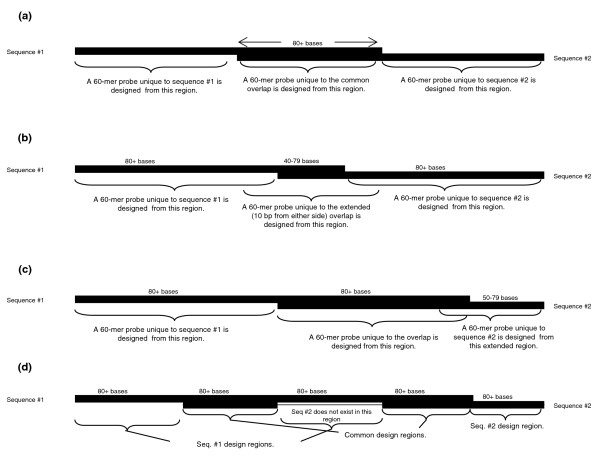
Examples of transcript clustering. Transcripts were clustered by BLAT and then aligned in ClustalW. Some of the more common clustering patterns are depicted. (a) Two transcripts, each with a unique region of at least 80 bases and a common region of at least 80 bases; (b) two transcripts, each with a unique region of at least 80 bases, and a common region between 40 and 79 bases; (c) two transcripts with a common region of at least 80 bases, a unique region of at least 80 bases and a unique region of at least 50 bases; (d) two sequences with a gapped alignment.